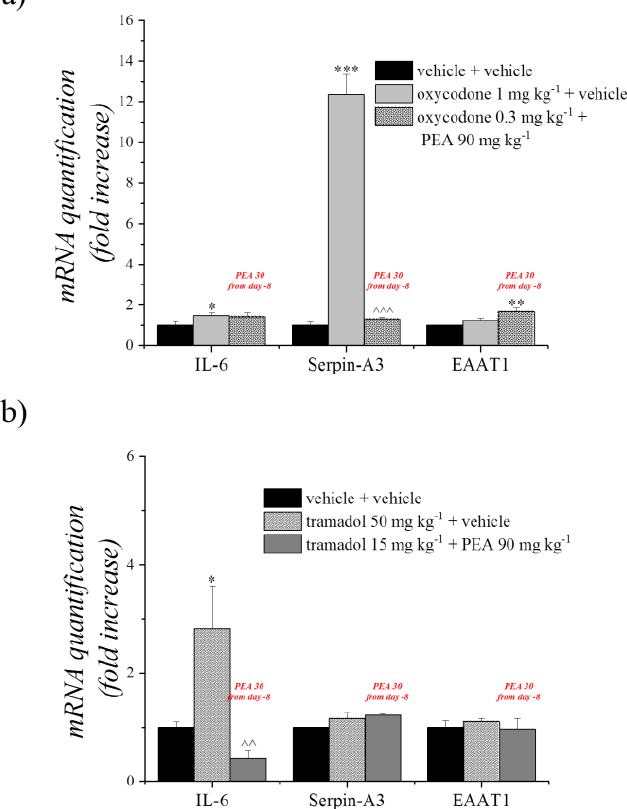
Figure 9. Effect of different combination of opioids and PEA on mRNA expression profiles in the lumbar spinal cord. Animals were orally treated with the vehicle or pre-emptive PEA (30 mg kg − 1 daily in the evening) for the duration of the experiment, starting on Day − 8. To maintain a significant increase in the pain threshold (90 ± 10 g) vs. the baseline, beginning on Day 1, daily increasing doses of ( a ) oxycodone (0.3–1 mg kg − 1 ), or oxycodone (0.3 mg kg − 1 ) and PEA (30–90 mg kg − 1 , p.o.) or ( b ) tramadol (15–50 mg kg − 1 ), or tramadol (15 mg kg − 1 ) and PEA (30–90 mg kg − 1 , p.o.) were injected s.c. On Day 31, the expression levels of IL-6, Serpin-A3 and EAAT1 genes were measured in the spinal cord. Each value represents the mean ± S.E.M. of three rats. Statistical analysis was one-way ANOVA followed by Bonferroni’s post hoc comparison. * p < 0.05, ** p < 0.01 and *** p < 0.001 vs. vehicle + vehicle